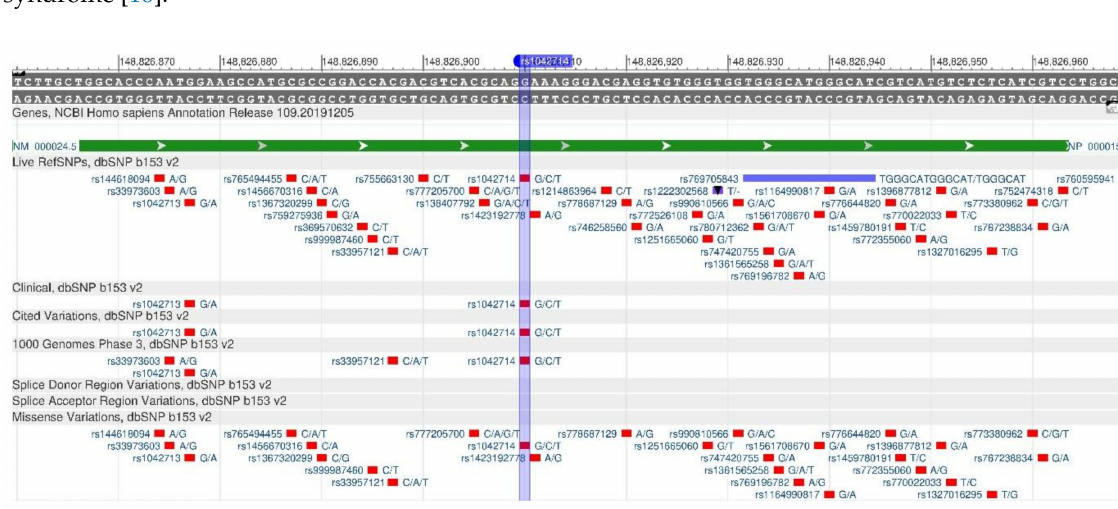
Figure 1. A portion of the ADRB2 gene (located on the long (q) arm of chromosome 5) containing the oligonucleotide polymorphism